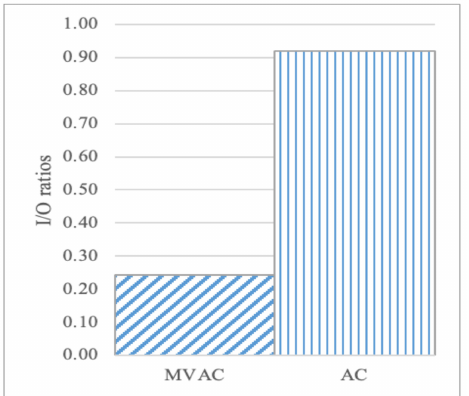
Figure 6. Indoor/Outdoor (I/O) ratio value for PM10 by type of ventilation